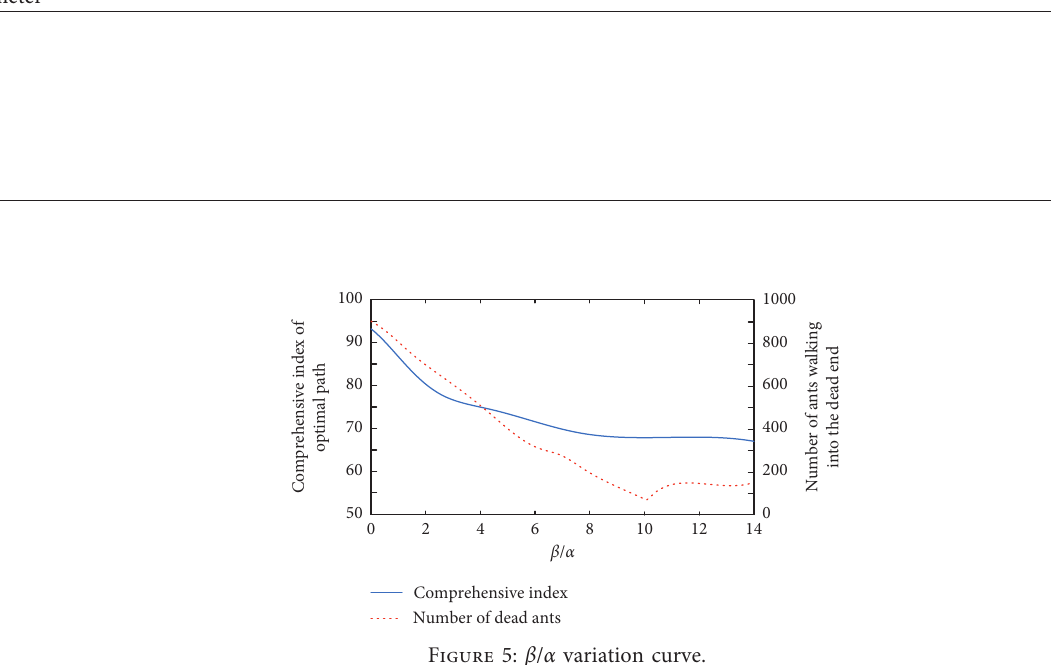
Figure 5: β / α variation curve.